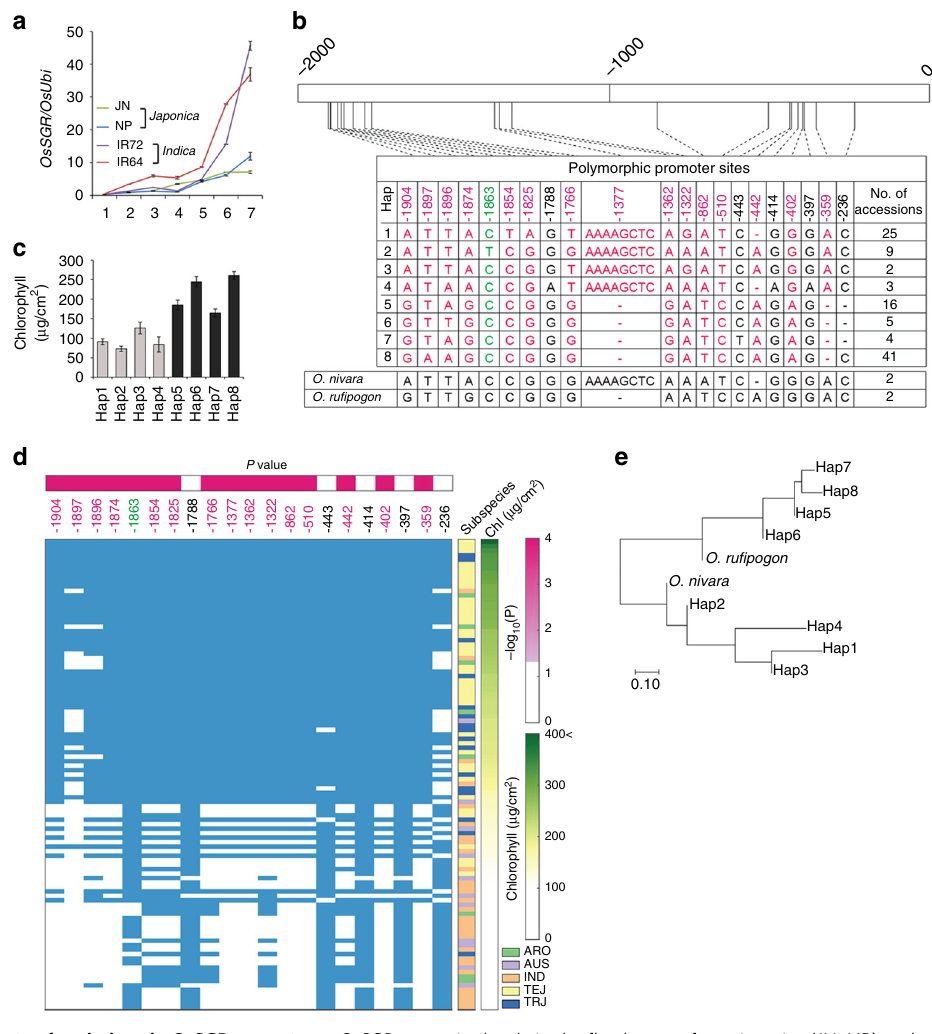
Fig. 3 Analysis of natural variations in OsSGR promoter. a OsSGR transcript levels in the fl ag leaves of two japonica (JN, NP) and two indica (IR72, IR64) cultivars measured at seven time points with 1-week intervals from 1 to 7 weeks after heading. Data are means (± SE) of three biological repeats. b Haplotype analysis of the polymorphic OsSGR promoter region from 105 accessions. These accessions showed 21 polymorphic sites in the 2-kb promoter region, which split into eight haplotypes (Hap). Note that IR72 and IR64 ( indica ) belong to haplotype 1 and JN and NP ( japonica ) to haplotype 8. Genetic variations of 2 O. nivara and 2 O. ru fi pogon accessions were also noted at the bottom. c Average chlorophyll concentration of the fl ag leaves in each of the eight haplotype plants at 6 weeks after heading. Data are means ± SE for each haplotype. d Association analysis between the promoter polymorphisms and the chlorophyll levels among the 105 accessions. The accessions (rows) are shown with major subspecies to which they belong (middle panel) and are sorted in descending order of their chlorophyll contents (right panel). For each polymorphism in the promoter (column in the left panel), shown is the signi fi cance (upper left panel) of the difference in chlorophyll content between the accessions of which DNA base are the same (blue boxes) and different (white) from those of japonica . The 16 polymorphic sites noted in red and green ( b , d ) are associated with chlorophyll level. The polymorphic sites in red are same to those between indica and japonica . e Phylogenetic tree of the eight haplotypes (Hap) and the two progenitor subspecies, O. nivara and O. ru fi pogon . Promoter alleles of indica (Haplotype 1) and japonica (Haplotype 8) are grouped with those of O. nivara and O. ru fi pogon , respectively. The scale bar represents the number of nucleotide substitutions per nucleotide position. Source data of Fig. 3a and c are provided as a Source Data fi